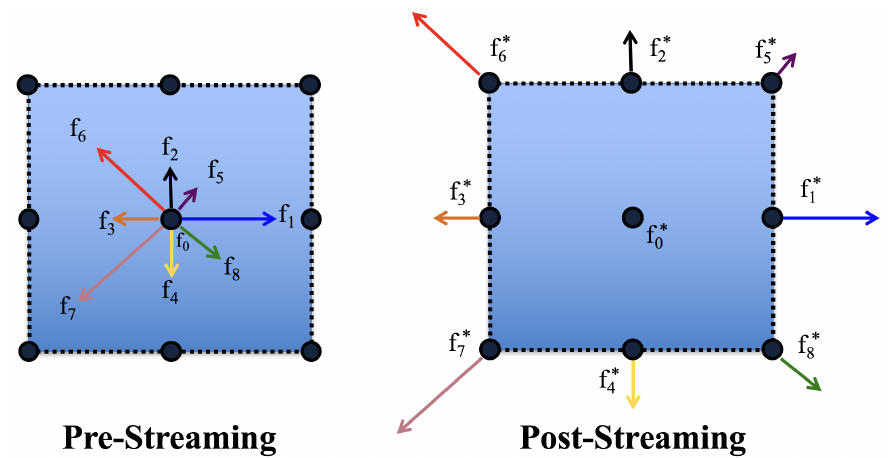
Figure A2. Figure illustrating the idea of streaming by showing color correlated particle probability functions, f i , before the streaming process and post-streaming, f ∗